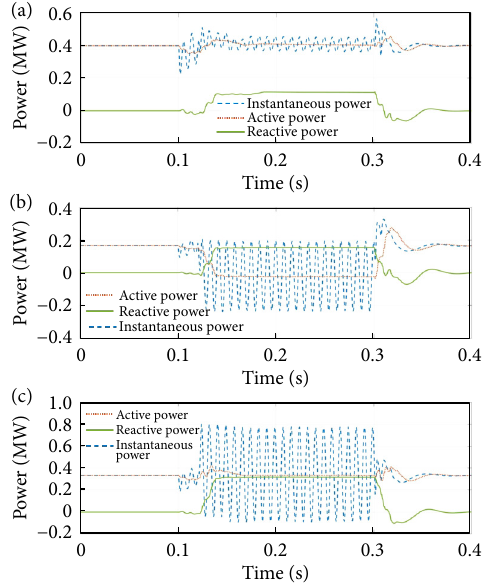
Fig. 18 Results for scalability analysis with 36 microgrids. ( a ) Timestamp signals are sent between RTDS simulators and the controller. ( b ) Microgrid 1’s phase currents are sent from the controller to RTDS simulators. ( c ) The mag- nitude difference between , and , i.e., , which are also fault current contributions from microgrids.